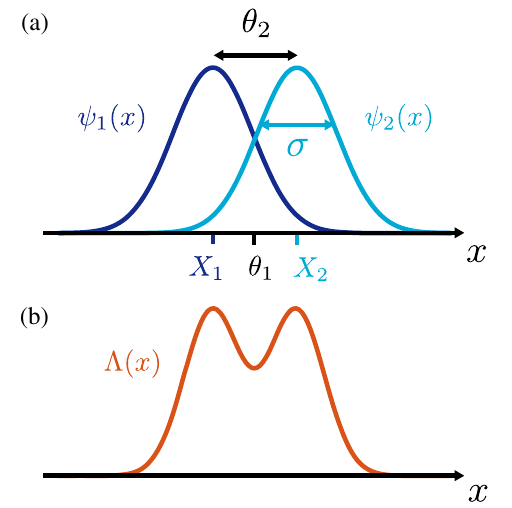
FIG. 1. (a) Two photonic wave functions on the image plane, each coming from a point source. X 1 and X 2 are the point-source positions, θ 1 is the centroid, θ 2 is the separation, and σ is the width of the point-spread function. (b) If photon counting is performed on the image plane, the statistics are Poisson with